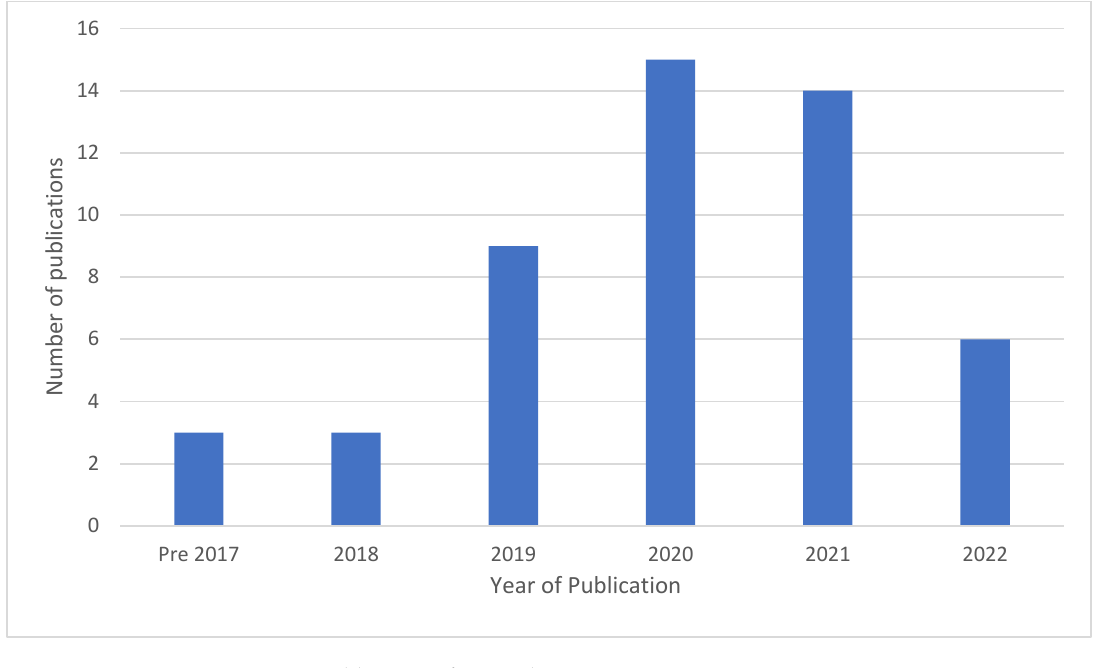
Figure 4. Publication of research.